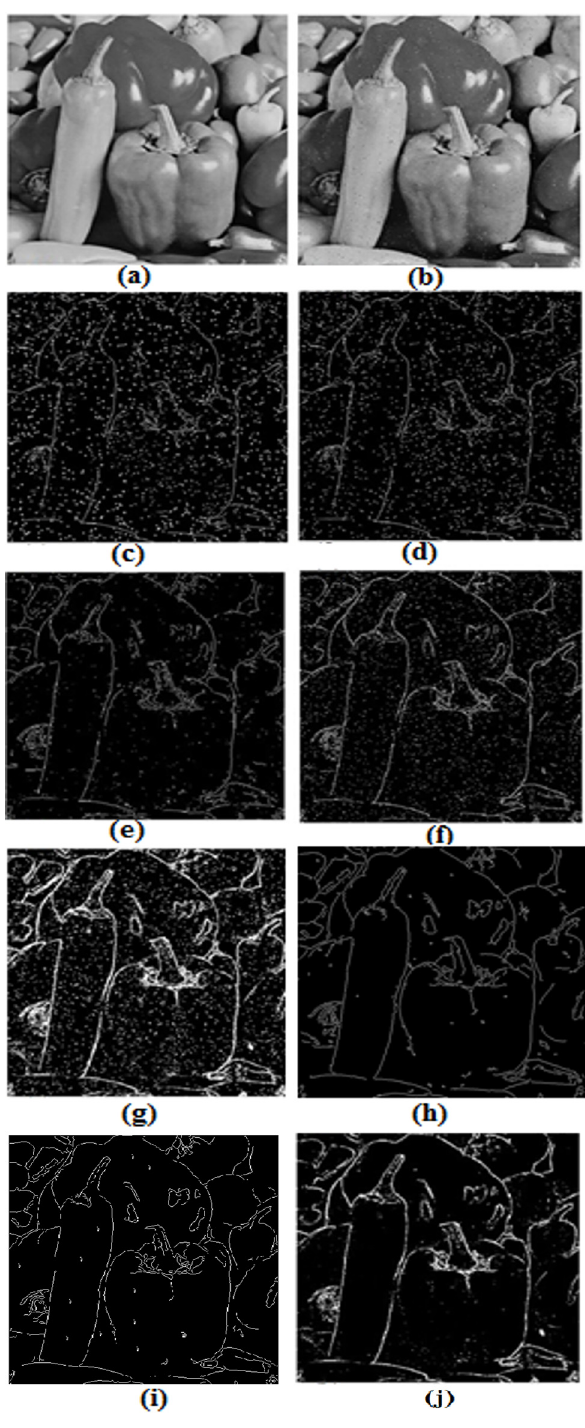
Fig 9. Comparison of experimental results in noisy image: (a) Original image, (b) Noisy image, (c) Sobel edge detection (d) Prewitt edge detection, (e) LoG edge detection, (f) Robert edge detection (g) Previously developed fuzzy based edge detection technique [22], (h) Canny edge detection and (i) The developed method. All the experimentation was performed on image